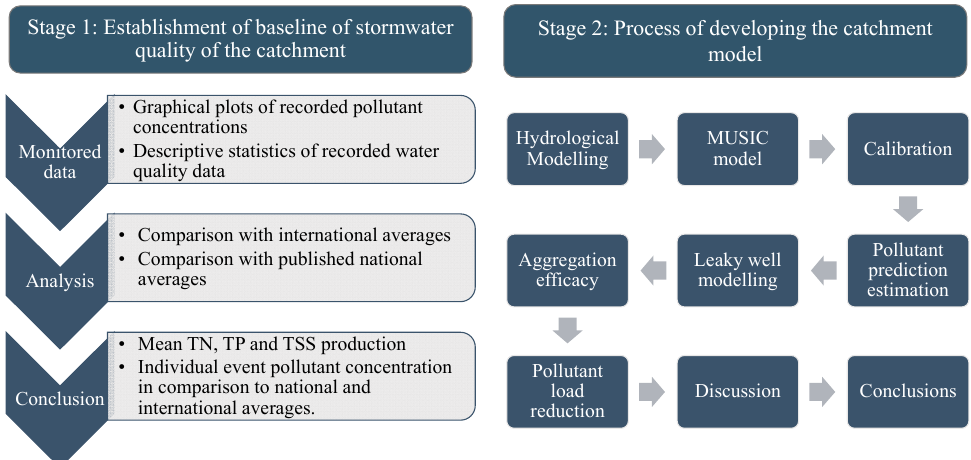
Figure 1. An overview of the methodology adopted to carry out the study.